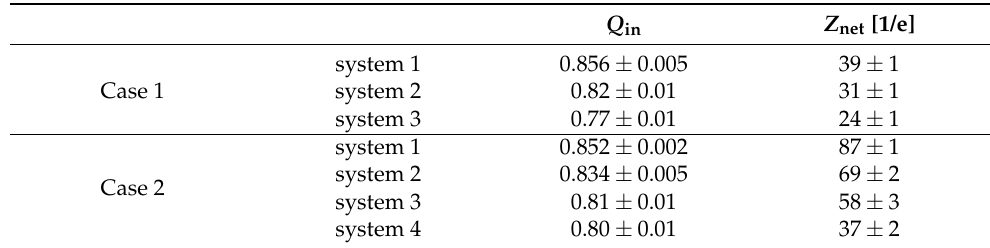
Table 2. Ratio of counterions inside the corona Q in and micelle net charge Z net for micelles from Figure